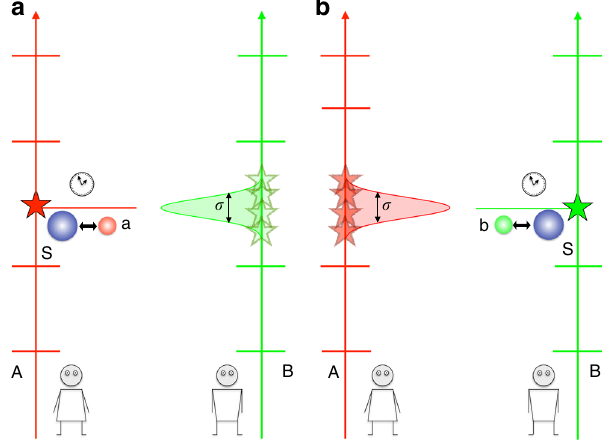
Fig. 2 Relative localisability of events for non interacting clocks with unsharp initial states. This fi gure describes the history state Ψ j i , solution to Eq. (3), in the time reference frame of A ( a ) and of B ( b ). There are two events, (depicted by a red and a green star), taking place in the experiment. In the event depicted by a red star, the system S, (depicted by the blue ball), interacts with A ’ s ancilla, a (depicted by a red ball). In the event depicted by a green star, the system S interacts with the ancilla b (depicted by a green ball), initially under the control of B. In A ’ s time reference frame ( a ), the event depicted by a red star is sharply localised in time. In contrast, the event depicted by a green star has an uncertainty, characterised by σ , in its time localisation, due to the “ fuzzy ” initial state of clock B in A ’ s time reference frame (see main text). The roles are reversed in the time reference frame of B ( b ). In this frame, it is the event depicted by a green star which is sharply localised in time (as de fi ned by clock B), whereas the event depicted by a red star exhibits some time uncertainty in B ’ s reference frame. This uncertainty is due to the fact that, in B ’ s frame, the initial state of clock A is “ fuzzy ”